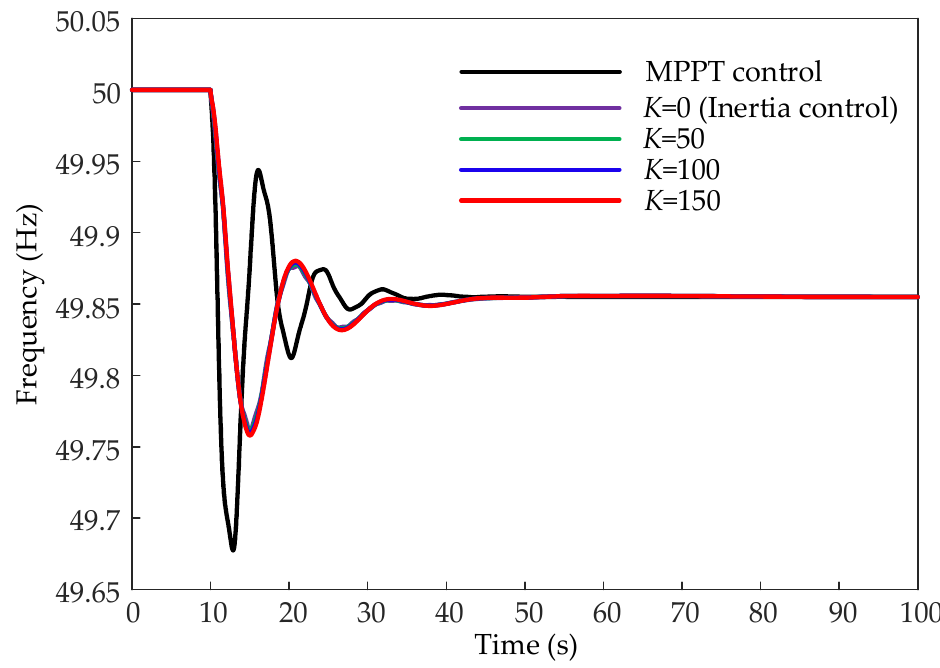
Figure 9. The frequency response curves of the system with different values of the damping control gain K ( K D = 40, K P = 10).